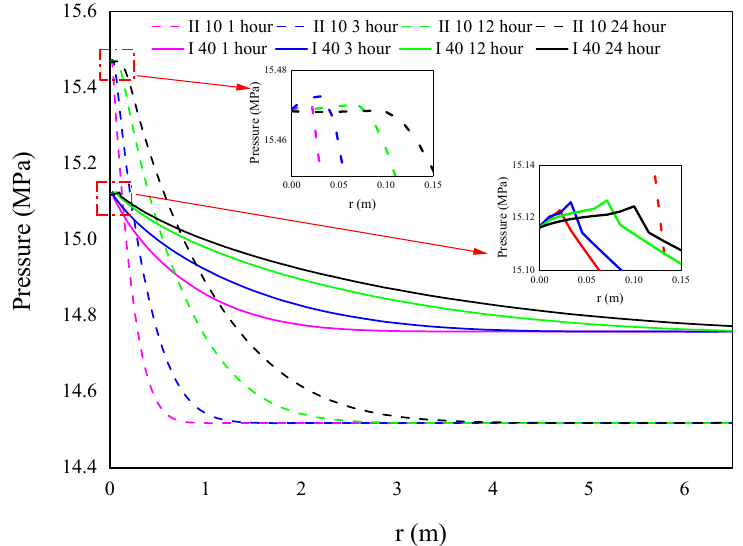
Figure 11. Pressure distribution curves of layer II at 10 m from the bottom of the reservoir and layer I at 40 m from the bottom of the reservoir under different drilling fluid invasion time conditions when the drilling temperature is 19 °C.